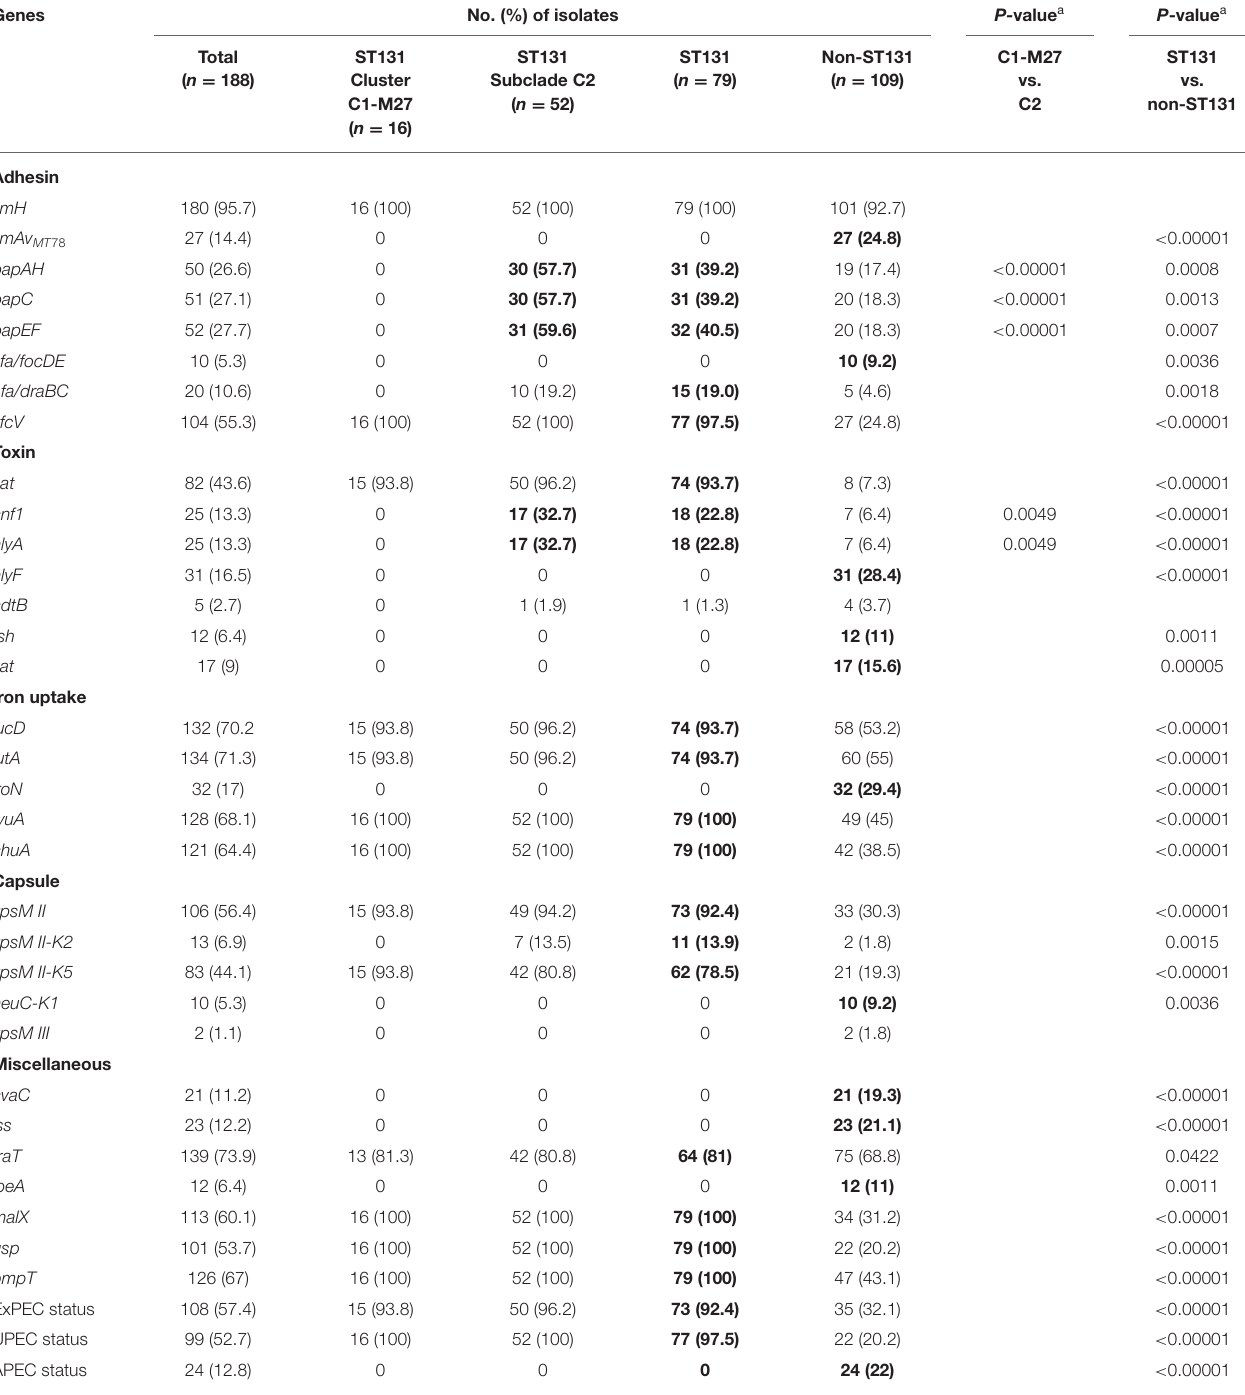
TABLE 4 | Virulence factor-encoding genes in the studied 188 isolates and according to ST131 lineage. Genes No. (%) of